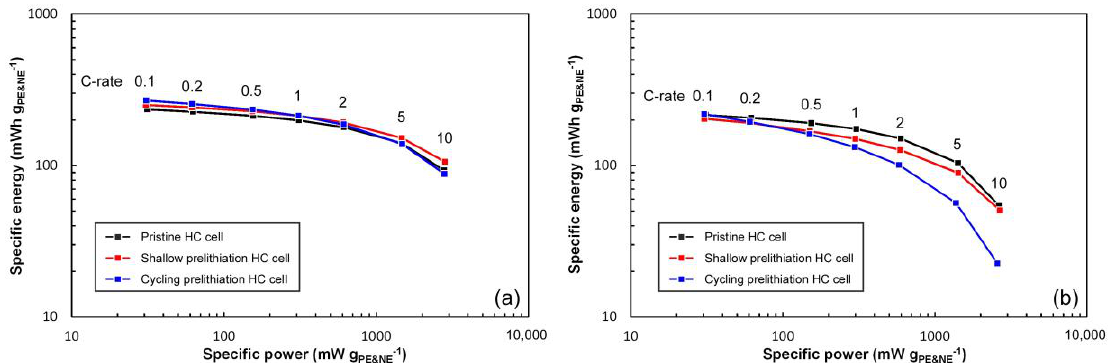
Figure 8. Relationship between specific power and specific energy of the full-cells with pristine and prelithiated HC NEs: ( a ) before cycling; ( b ) after cycling. In the graphs, 1 C-rate is equal to 170 mA g PE−1 .